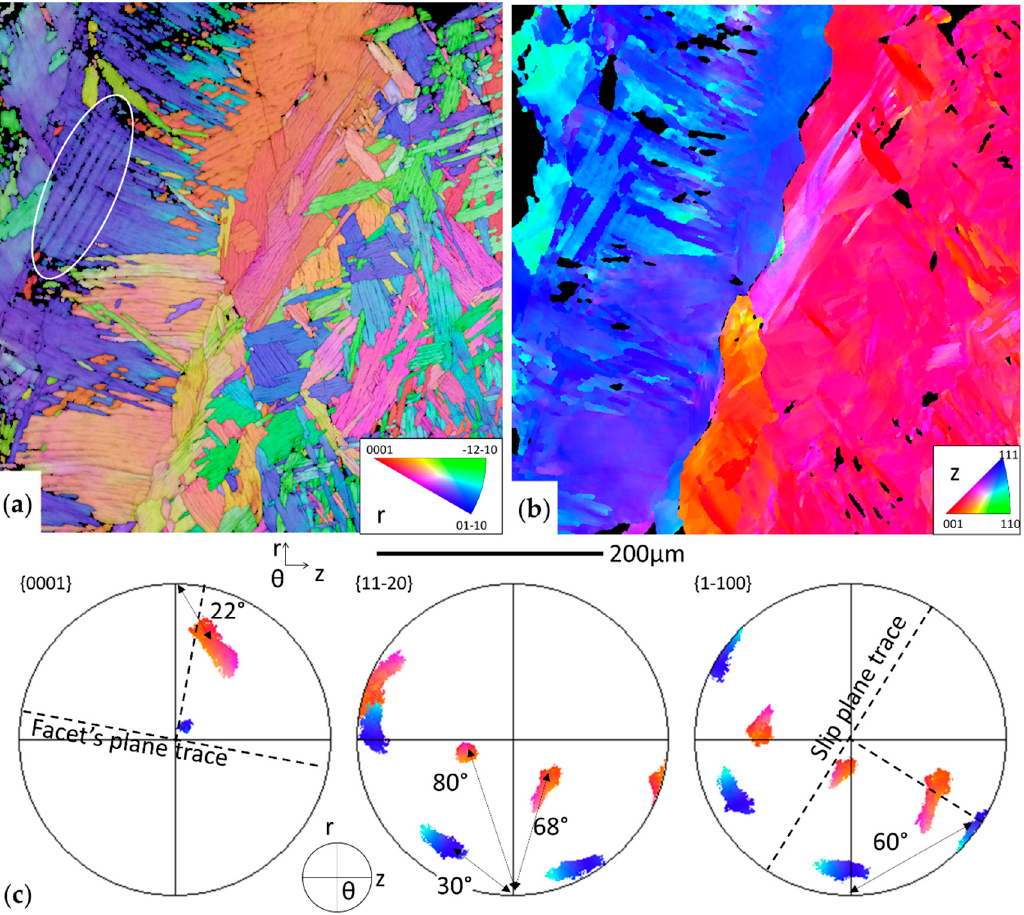
Figure 7. EBSD map over the section transverse to the facet seen in Figure 4b,c: ( a ) measured α IPF // z map; ( b ) Reconstructed β IPF // z map; ( c ) α orientations plotted as PFs of two specific colonies, the red one below the facet and the blue one with deformation marks and additional dotted traces of facet and slip